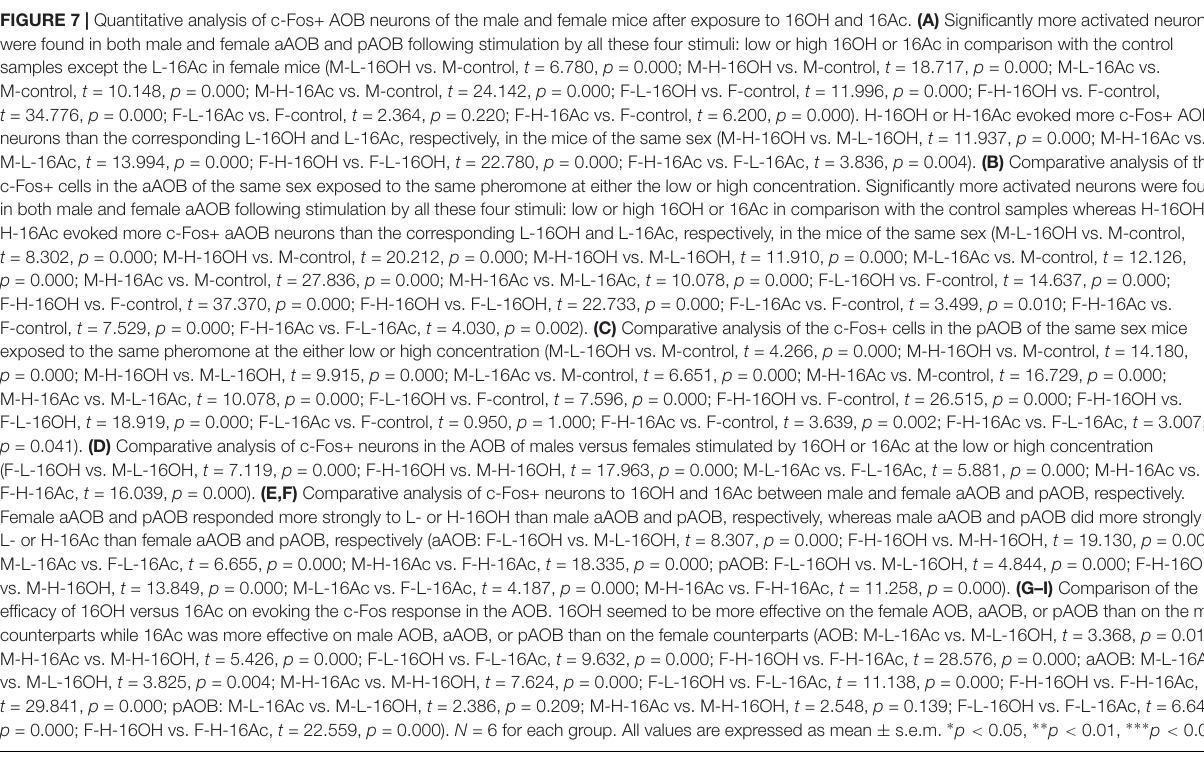
Frontiers in Cellular Neuroscience |